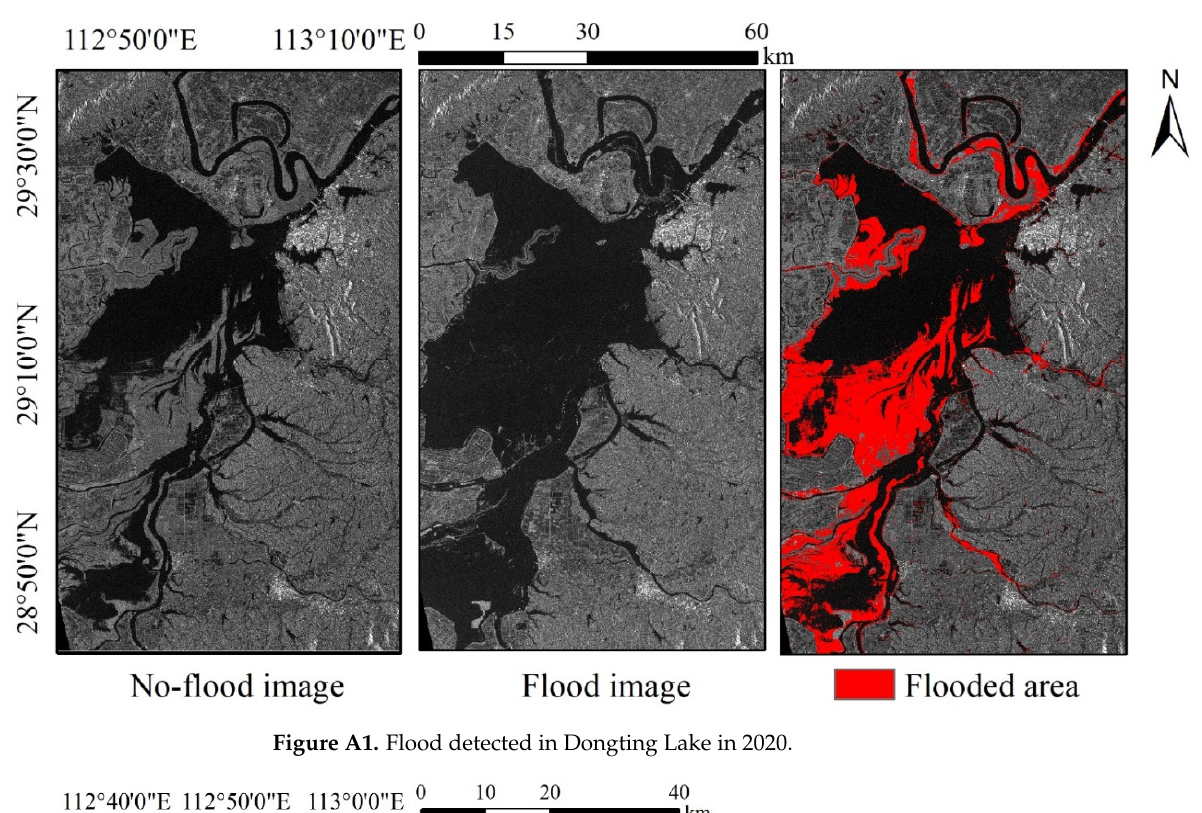
Figure A1. Flood detected in Dongting Lake in 2020.